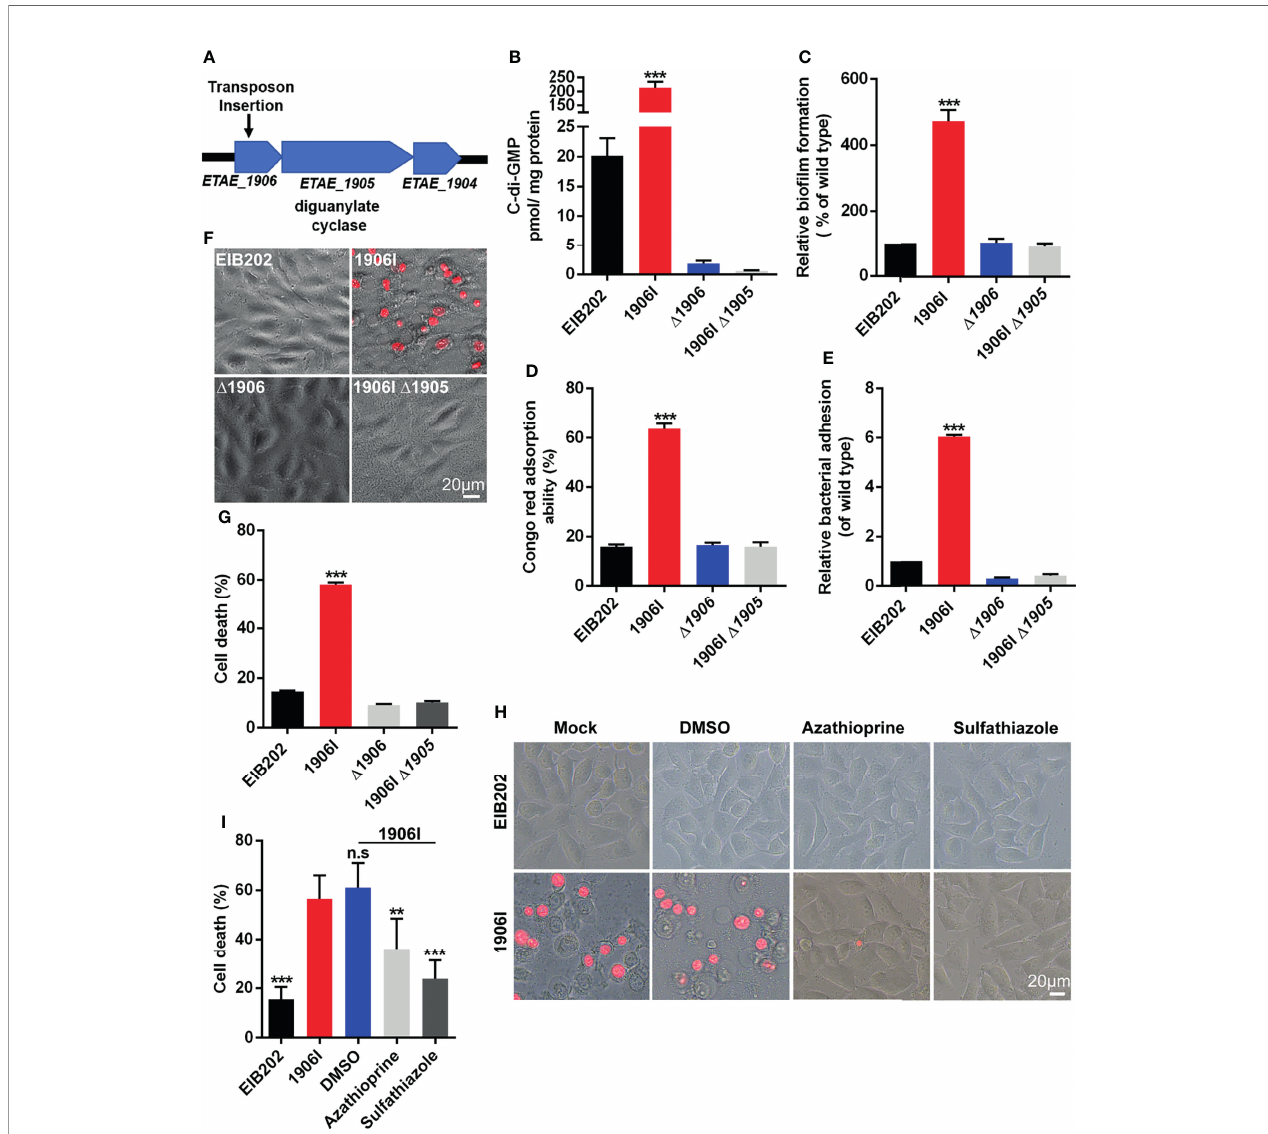
FIGURE 2 | Upregulated c-di-GMP in 1906I strain promoted robust membrane-ruptured cell death. (A) A schematic of transposon insertion location in the genome of 1906I strain. (B) Cytosolic c-di-GMP levels of indicated E. piscicida strains. (C) Bio fi lm formation of indicated E. piscicida strains detected by crystal violet staining method. (D) Exopolysaccharide production indicated by Congo red adsorption of indicated E. piscicida strains. (E) Bacterial count by agar plating cell lysates from HeLa cells infected by indicated E. piscicida strains (MOI = 100, 1 hpi) after 3 times washing with cold PBS to remove unattached bacteria. (F, G) Cell morphology with PI staining (F) and LDH release (G) of Hela cells after infection with indicated E. piscicida strains (MOI=25, 5 hpi). Scale bar, 20 m m. (H, I) Cell morphology with PI staining (H) and LDH release (I) of HeLa cells infected with E. piscicida EIB202 or 1906I (MOI=25, 5 hpi) in the presence of c-di-GMP synthesis inhibitor azathioprine (50 µg/ml), sulfathiazole (100 µg/ml), DMSO. Scale bar, 20 m m. Results are representative of at least three independent experiments, and error bars denote SD of triplicate wells. ** P < 0.01, *** P < 0.001; n.s, not signi fi cant. (One-way